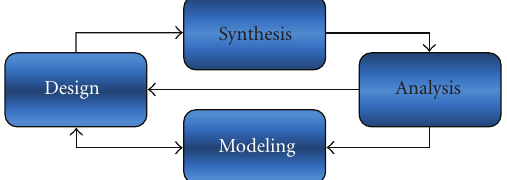
Figure 1: Synthetic biology four-step engineering workflow. The design and modeling steps (white text) are computational in nature, whereas the synthesis and analysis steps (black text) are experimentally-based. The workflow presents the relationships between the individual steps as well as a logical progression using a synthetic biology framework to generate a product that meets determined